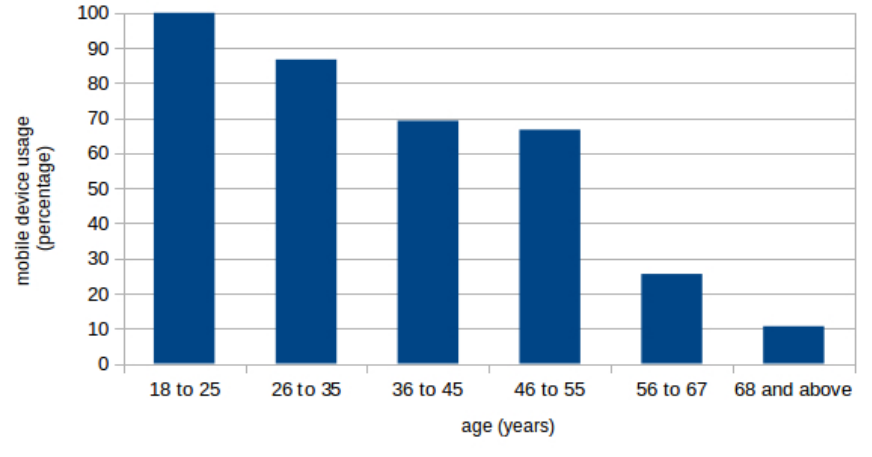
Figure 2. Availability/ownership of mobile devices within different age